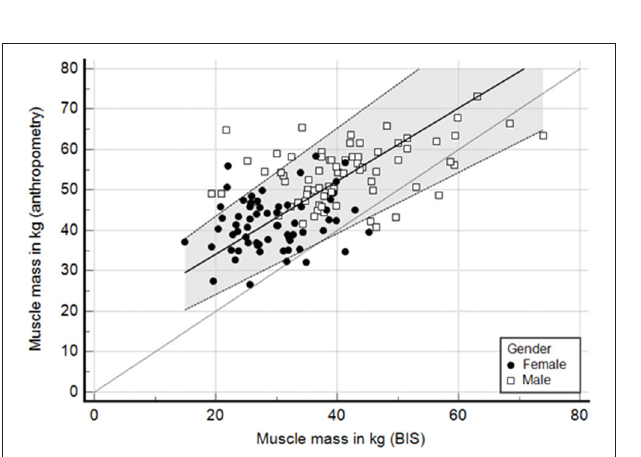
FIGURE 4 | Passing and bablok regression—correlation of muscle mass (kg) between anthropometry and BIS. Lins concordance 0.33.